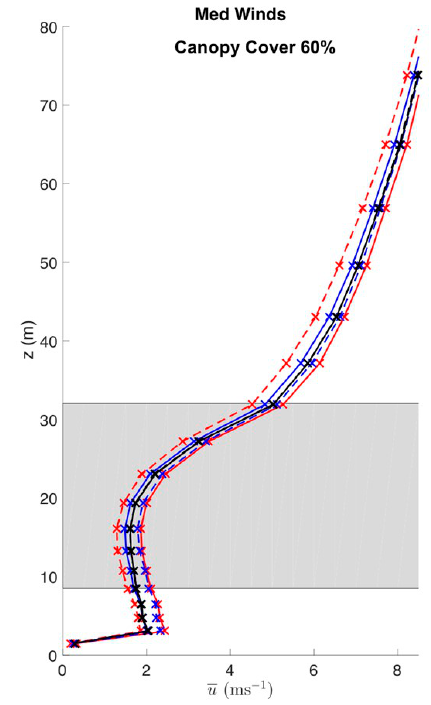
Figure 7. Spatially and temporally averaged vertical profiles characterizing streamwise (forward) wind flow velocity, U , on the x axis, with increasing height on the y axis. Lines with X’s represent 60% cover cases while lines without X’s represent 30% cover cases. Red lines show profiles for high aggregation cases, blue lines show moderate aggregation cases and black lines show low aggregation cases. The spread of profile lines of similar colors illustrates differences in winds arising from interactions between fuel spatial patterns, ambient winds, and the fire; differences between replicates are highest for high aggregation cases. The gray area indicates the vertical range within which the canopy is found.